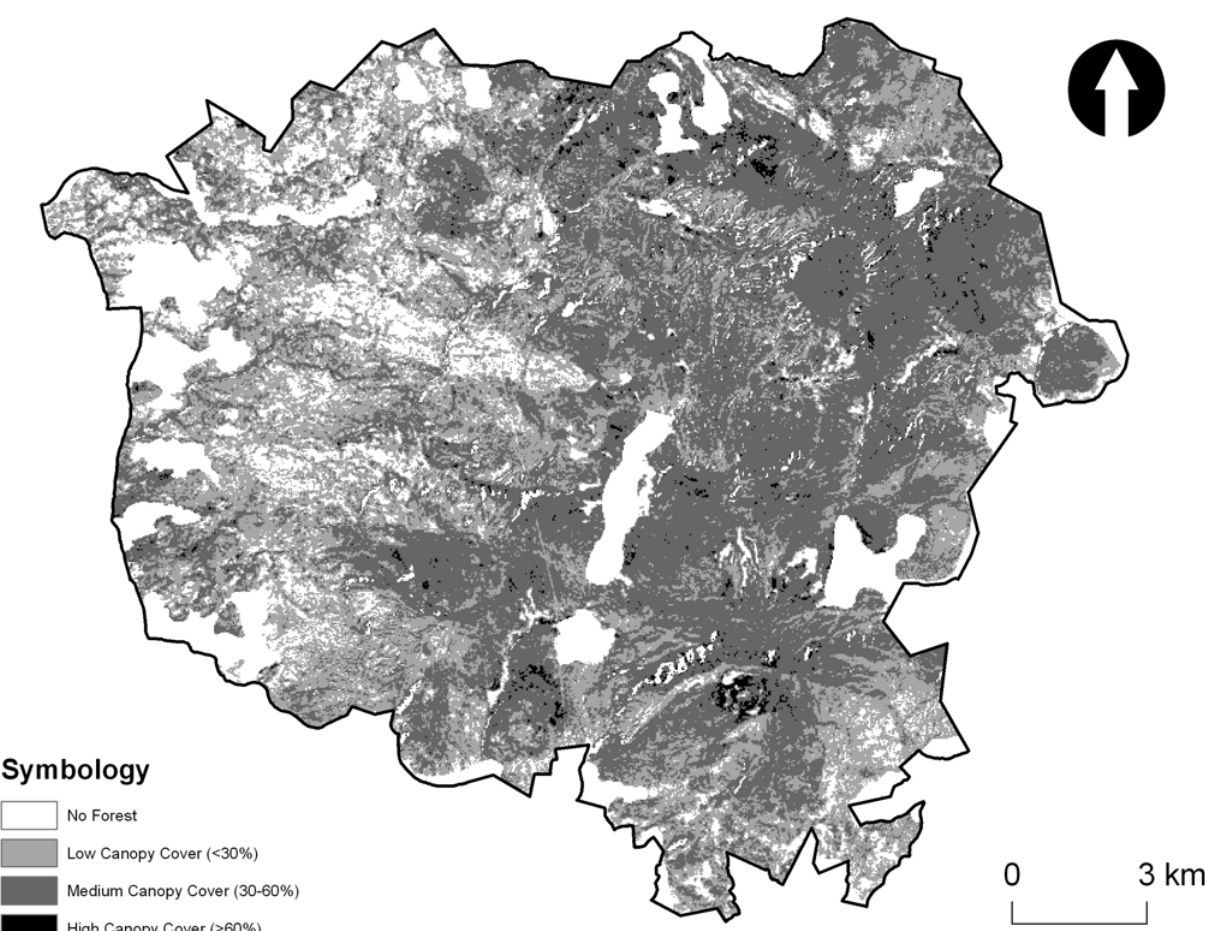
Figure 2. La Primavera, Landsat 5 image classified by canopy cover